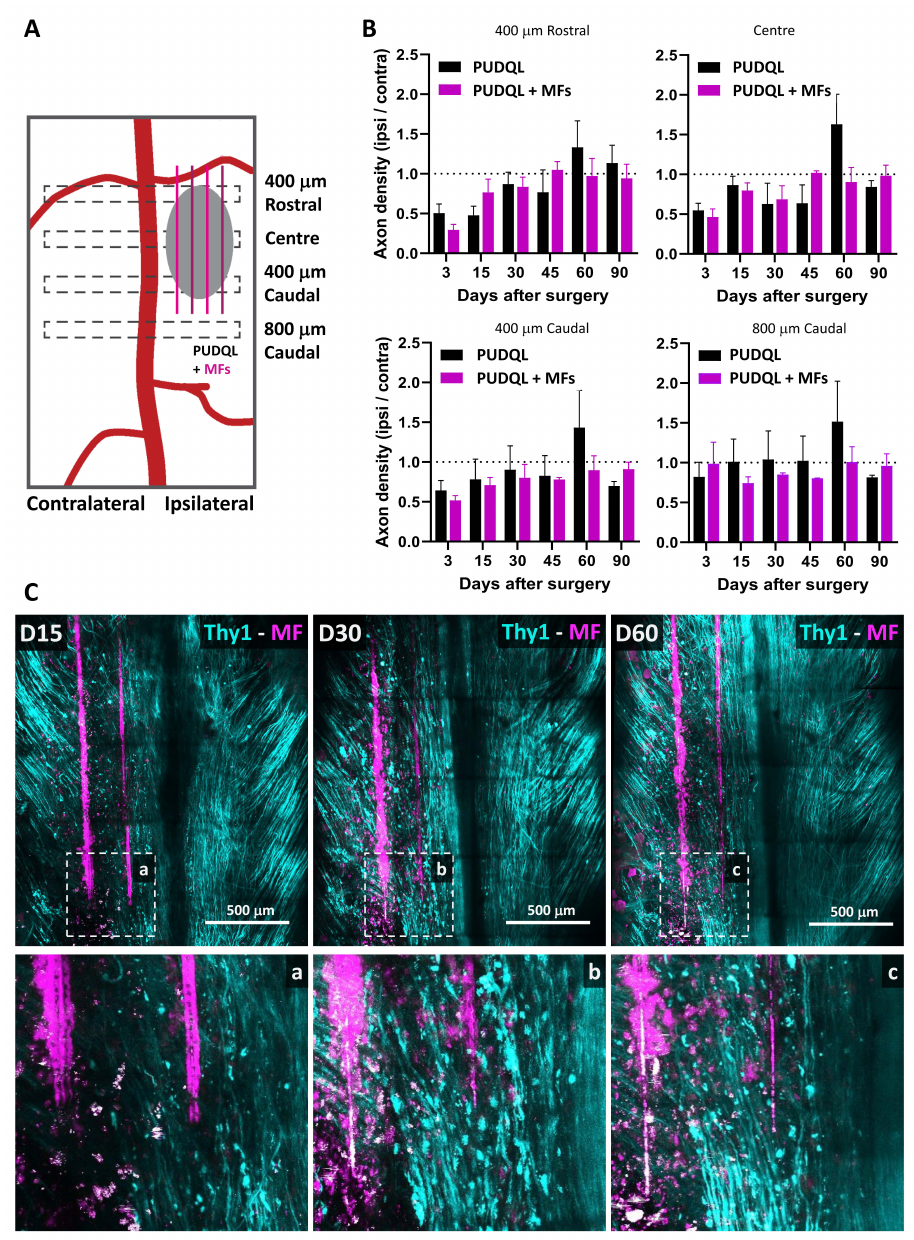
Figure 7. Effects of MFs on axon growth and guidance. ( A ) Schematic representation of the regions where axons were counted relatively to the location of the PUDQL+ MFs. ( B ) Comparative evolution of the normalized axonal density over 90 days after PUDQL (black; n = 5) or PUDQL followed by MF implantation (pink; n = 5). The increased sprouting observed on day 60 (D60) in PUDQL mice was greatly reduced with MF implantation. Data are shown as mean ± SEM. ( C ) Representative images of the same region of the spinal cord 15, 30 and 60 days following PUDQL. High magnification image of the same region outlined by a dotted square (bottom a, b and c). Note that the damaged axonal network at D30 was replaced by a dense and straight array of axons gradually regenerating and densifying along MFs over two